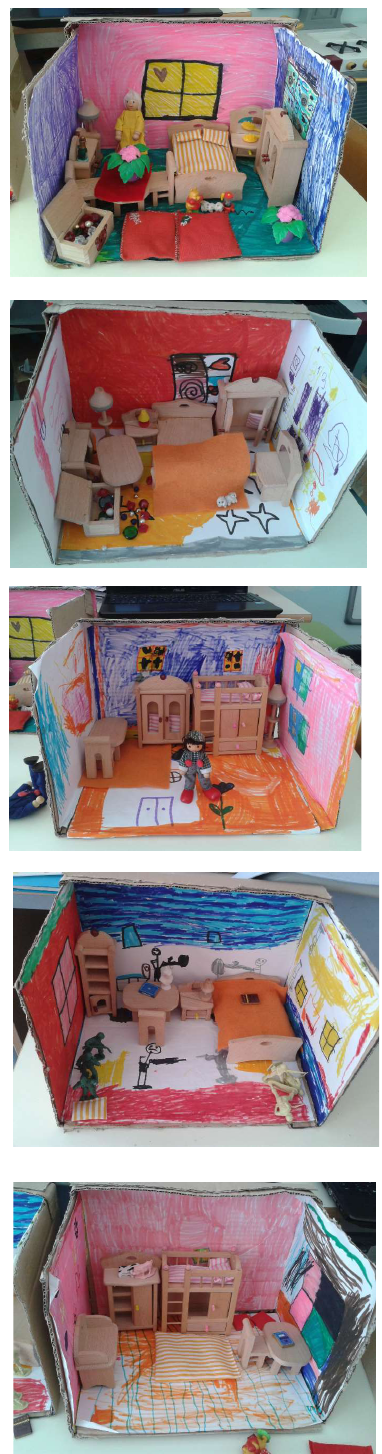
Figure 2: Examples of bedrooms created by